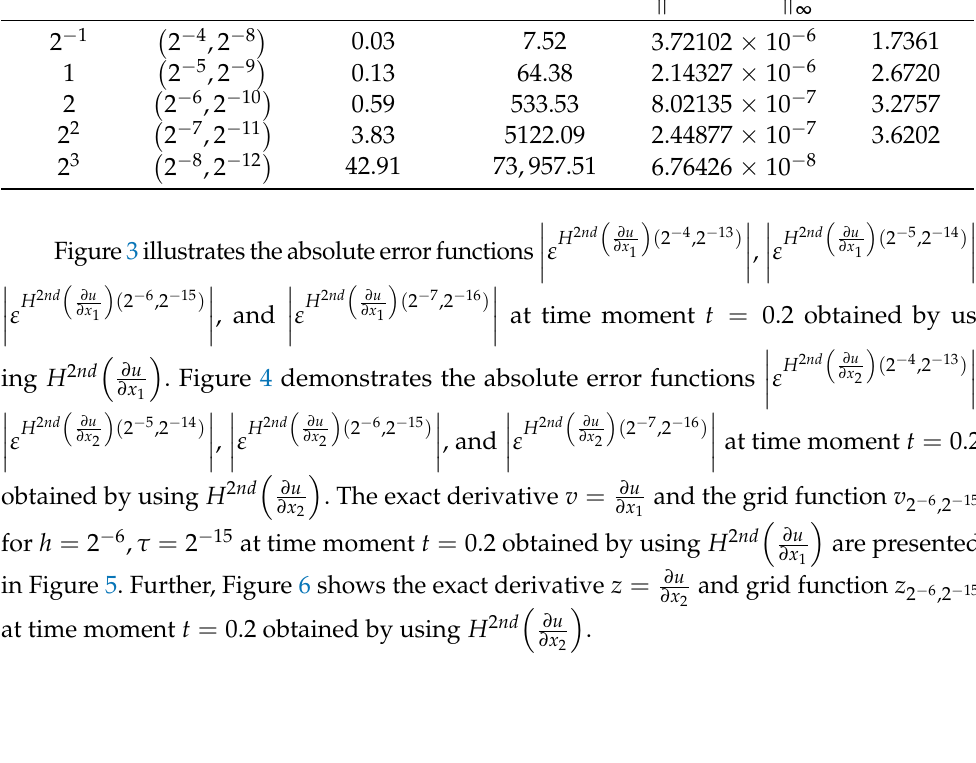
Table 3. Computational time, maximum norm of the errors, and the order of convergence of v h , τ to the exact derivative v = ∂ u